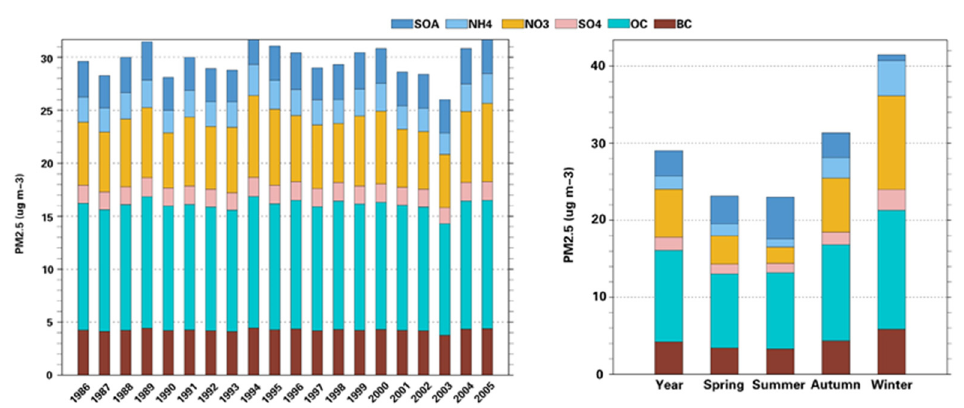
Figure 5. The year averaged surface concentration of PM 2.5 , BC, OC, SO 4 , NO 3 , NH 4 , and SOA in 1986 – 2005.